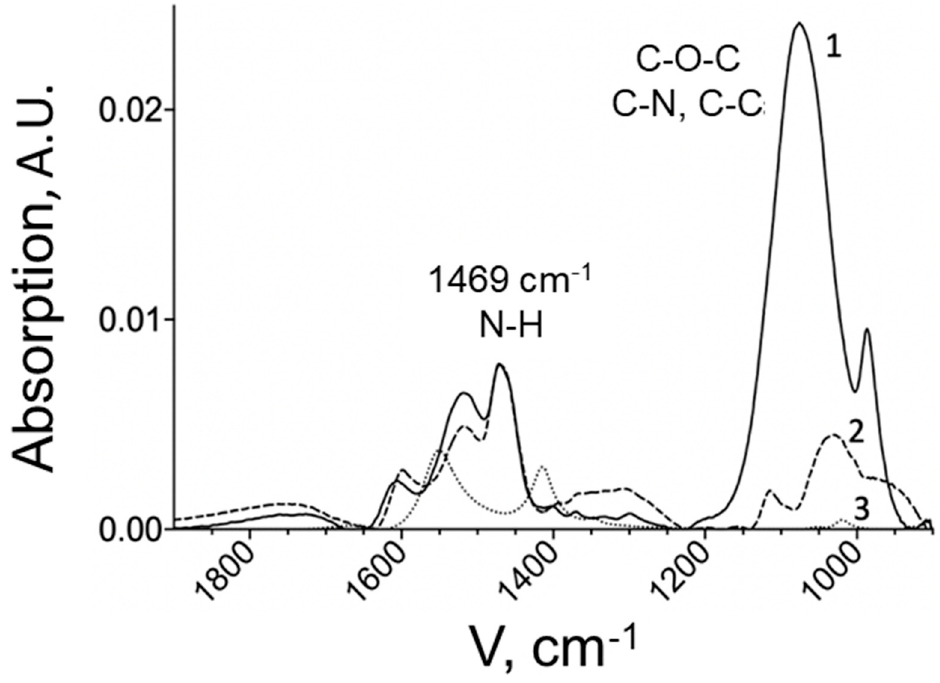
Figure 3. IR spectra of chitosan-PEI copolymer ( 1 ), PEI 10 mg/mL ( 2 ), chitosan 5 kDa 1 mg/mL ( 3 ) in 10 mM PBS pH 7.5, 25 °C. A.U., arbitrary units.